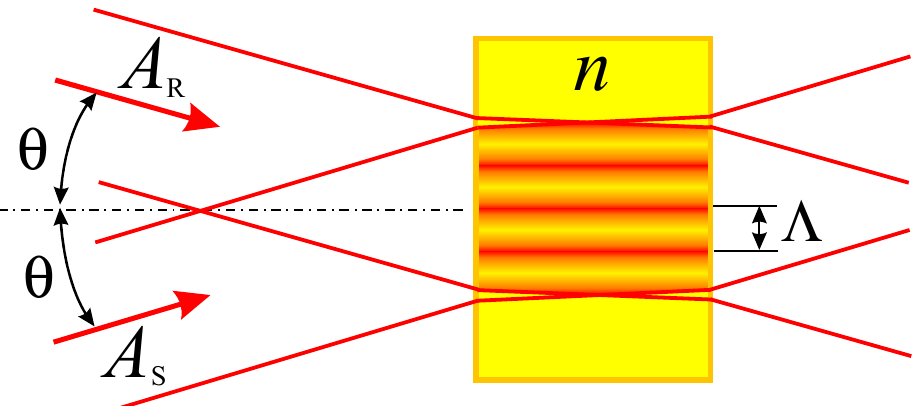
Figure 1. Interference of two plane waves A R —reference wave and A S —subject wave in a medium with a refractive index n . The period of interference pattern is Λ = λ /2sin θ , where λ —is the wave- length, θ —incidence angle.